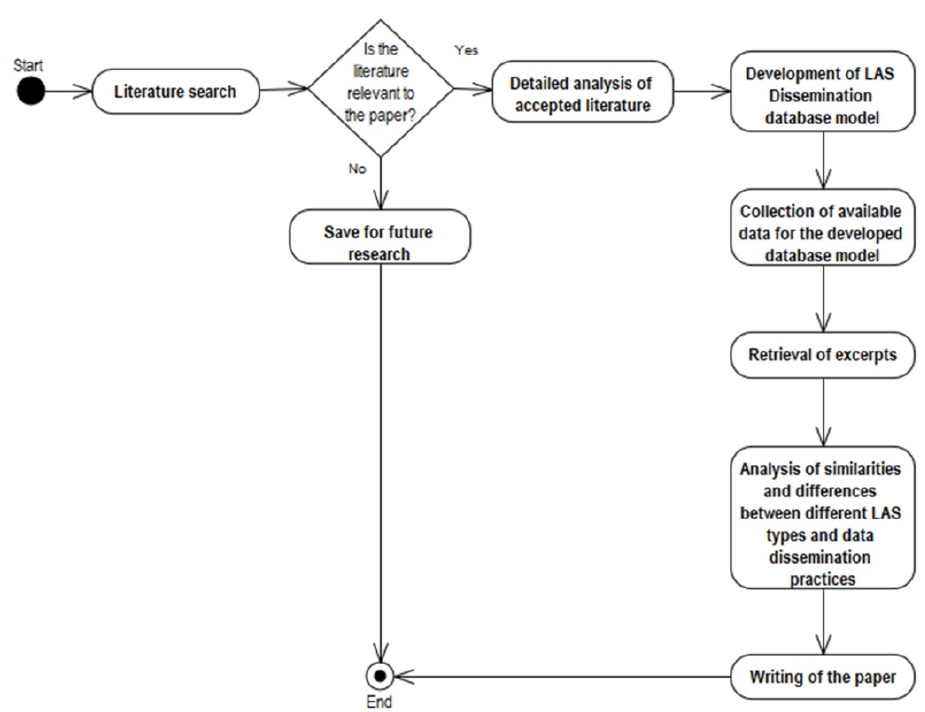
Figure 1. Research Workflow. Source: Own compilation.